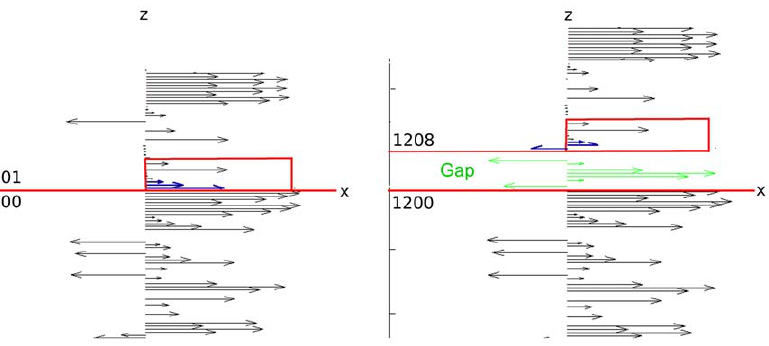
Figure 4. Autoregression in the W-curve after a gap inserted into sequences. The gap (green, right panel) offsets the matching portion of the right curve by seven bases. After three bases for the curves to converge (shown in blue) the curves converge again. Comparing bases 1204 and 1211 (gap + convergence window) will show the curves aligning.